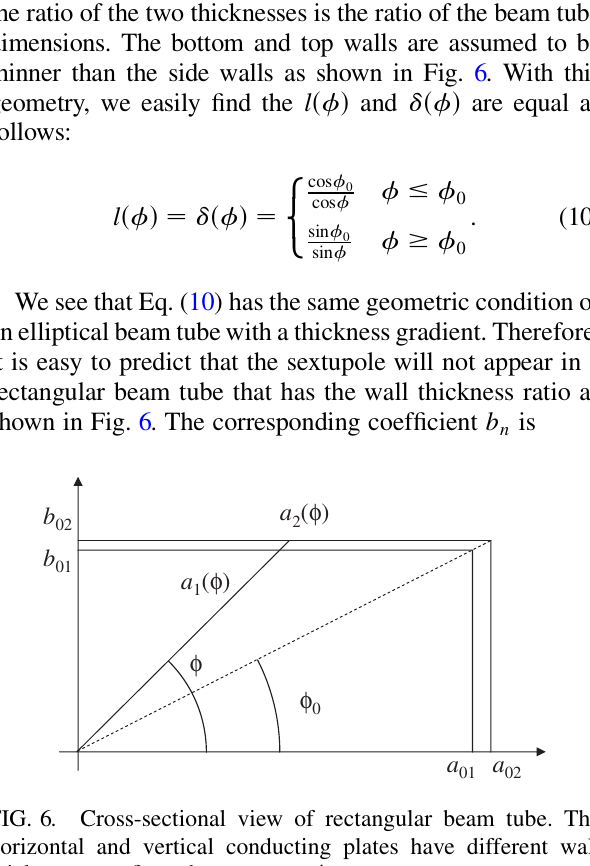
FIG. 4. Elliptic cross section with thickness gradient. The thickness is a function of effective radius D ð (cid:4) Þ ¼ (cid:7)R ð (cid:4) Þ n (cid:2) 2 . The equivalent normalized expression is (cid:6) ð (cid:4) Þ ¼ l ð (cid:4) Þ n (cid:2) 2 . This model enables the deletion of selected harmonics of order n .